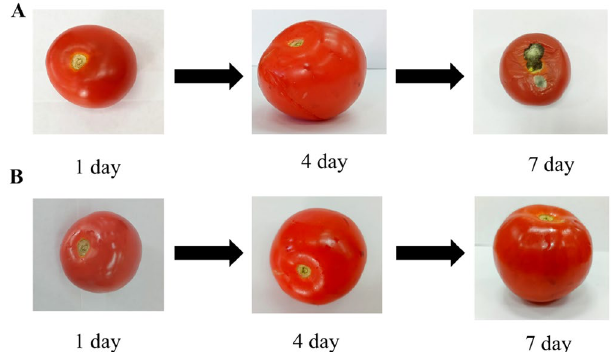
Figure 19. Photo of tomato samples: ( A ) control sample without nanopackaging, ( B ) experimental sample with nanopackaging.